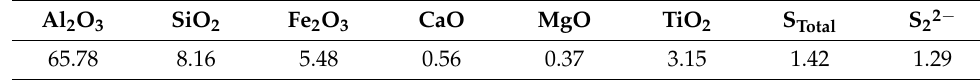
Figure 1. XRD pattern of high-sulfur bauxite. Table 1. Chemical composition of high-sulfur bauxite in wt.%.